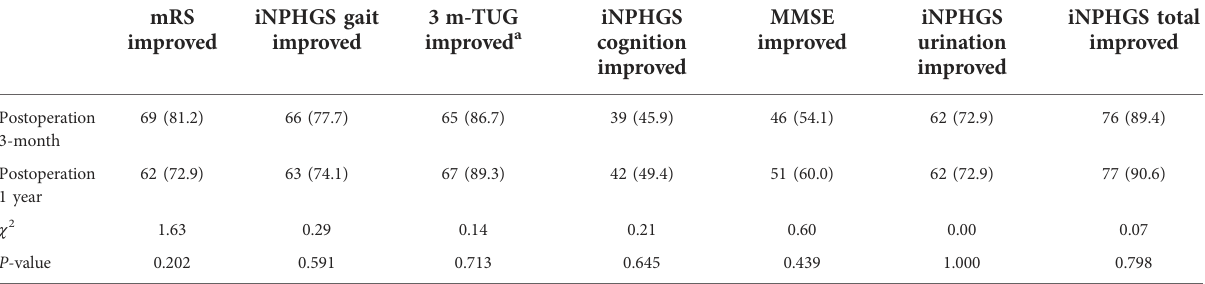
TABLE 3 Comparison of improvement rates of symptoms and functions at different postoperative times [ n